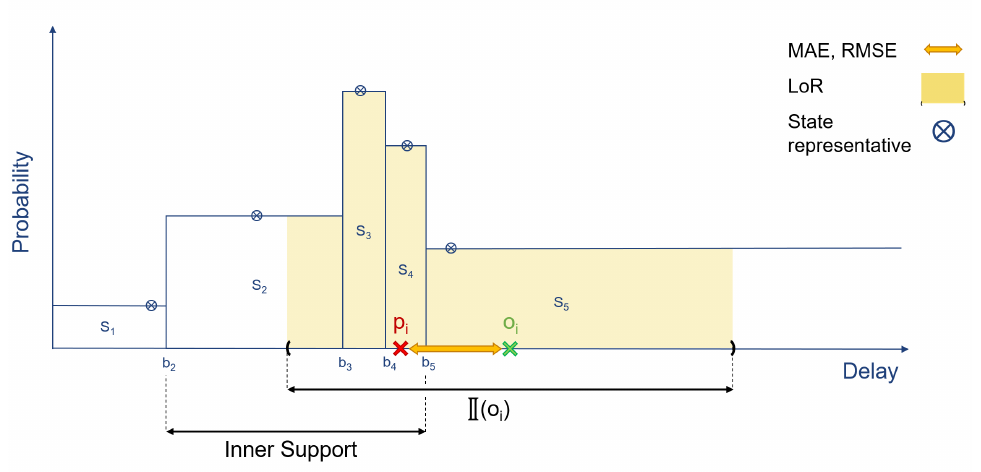
Figure 7. Visualization of evaluation methods for an exemplary probabilistic delay prediction (step- function) with five